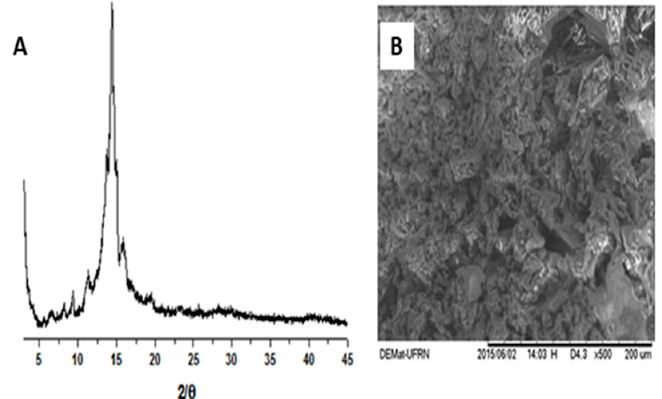
Figure 3. X-ray diffraction pattern of α , β -amyrenone ( A ); and surface morphological appearance of α , β -amyrenone ( B ).